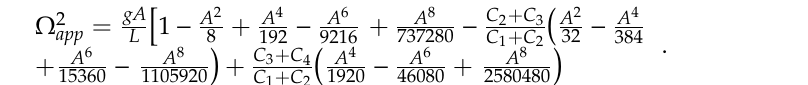
Figure 20. Comparison between the approximate solution (50) and numerical integration results for